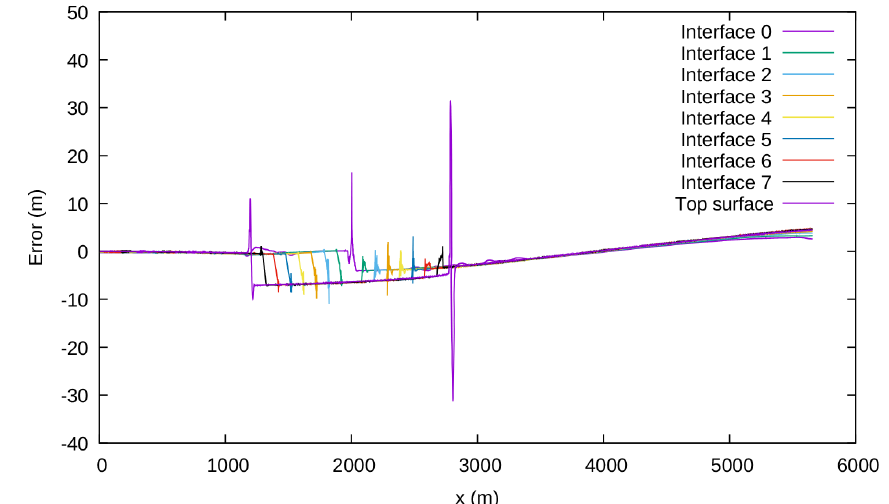
Figure 14. Error on the restoration of the interfaces in the model. The lower the number of the interface, the lower the interface it corresponds to. For example, interface 0 is the interface between the salt and the lowest sediment